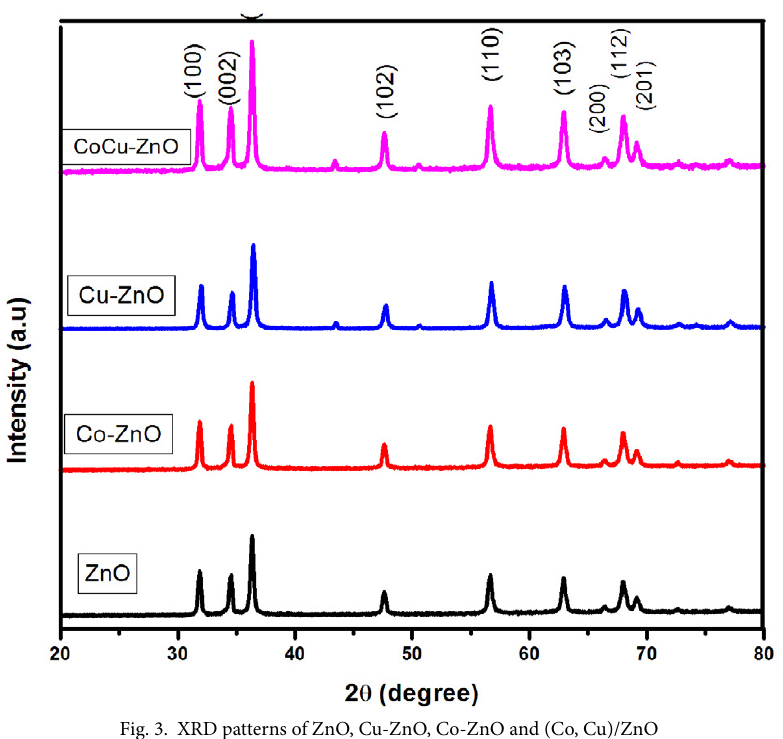
Fig. 3. XRD patterns of ZnO, Cu-ZnO, Co-ZnO and (Co, Cu)/ZnO